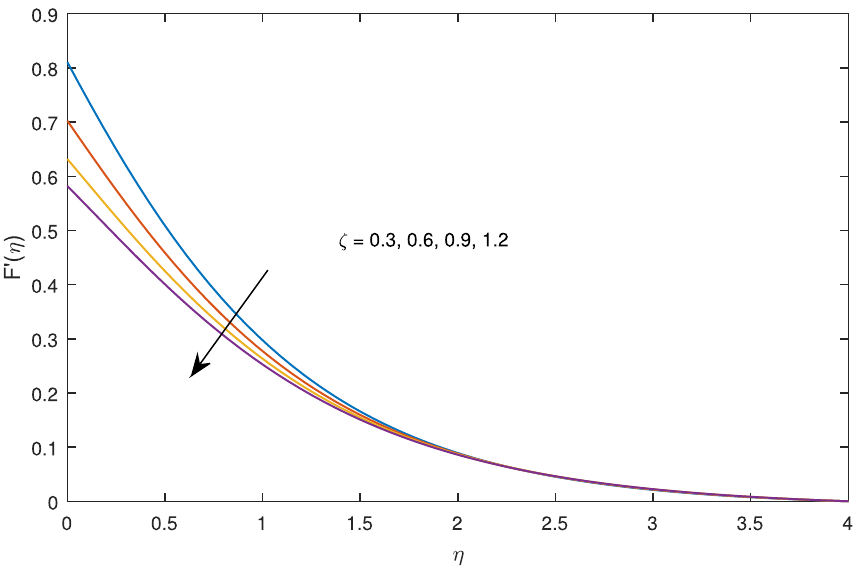
1 , w 0.1 and 0.5 , β 0.2 , N 0.2 , φ rd = = = = ◦ =